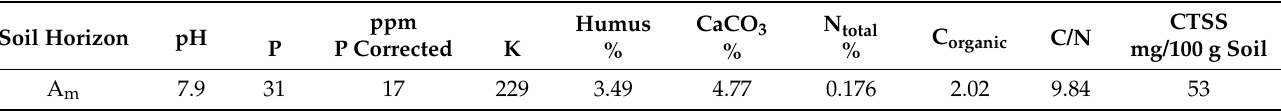
Table 3. Chemical analysis of Am (molic) horizon soil used for